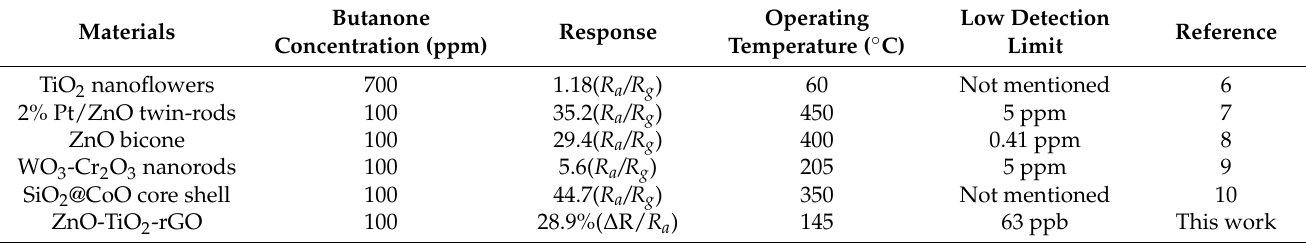
Table 2. Comparison of the sensing performance toward the detection of butanone of different sensors. Butanone Materials Concentration (ppm)